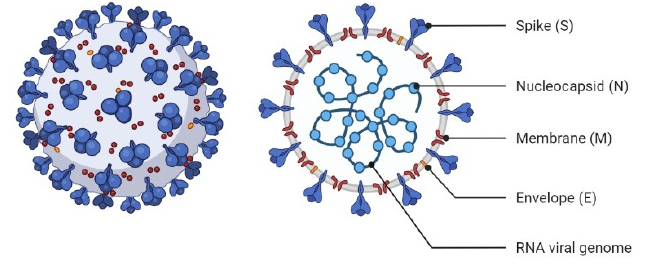
Figure 1. A schematic of the human coronavirus